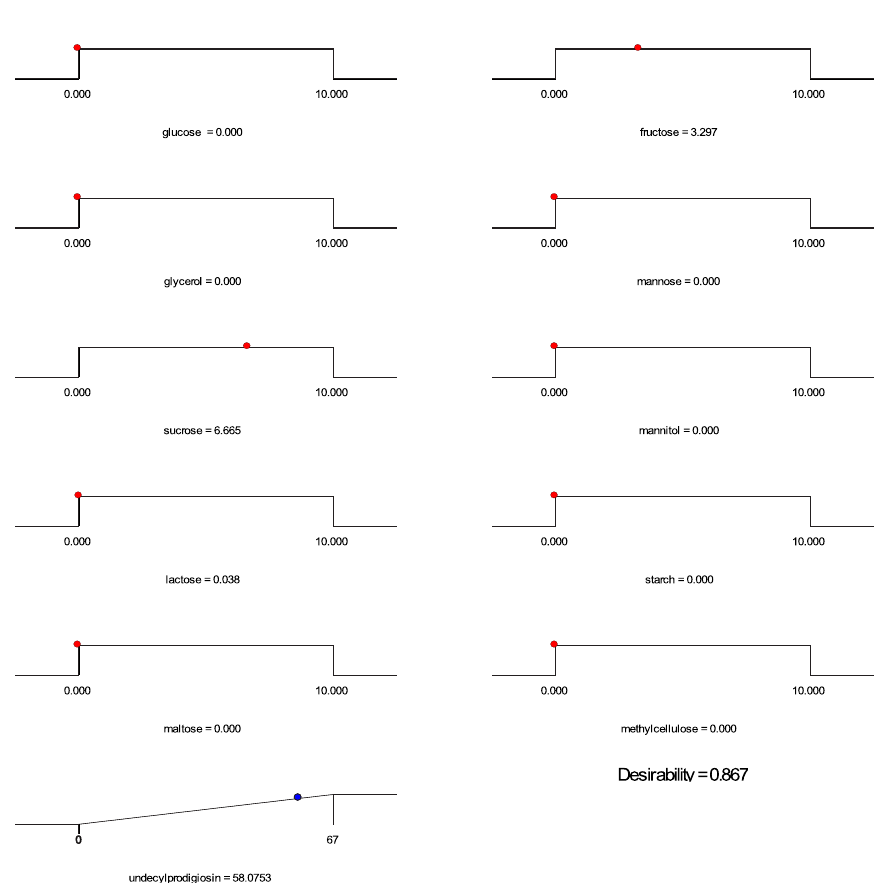
Fig. 3. Ramp chart for statistically optimize carbone source for undecylprodigiosin production by Streptomyces coelicolor A(3)2